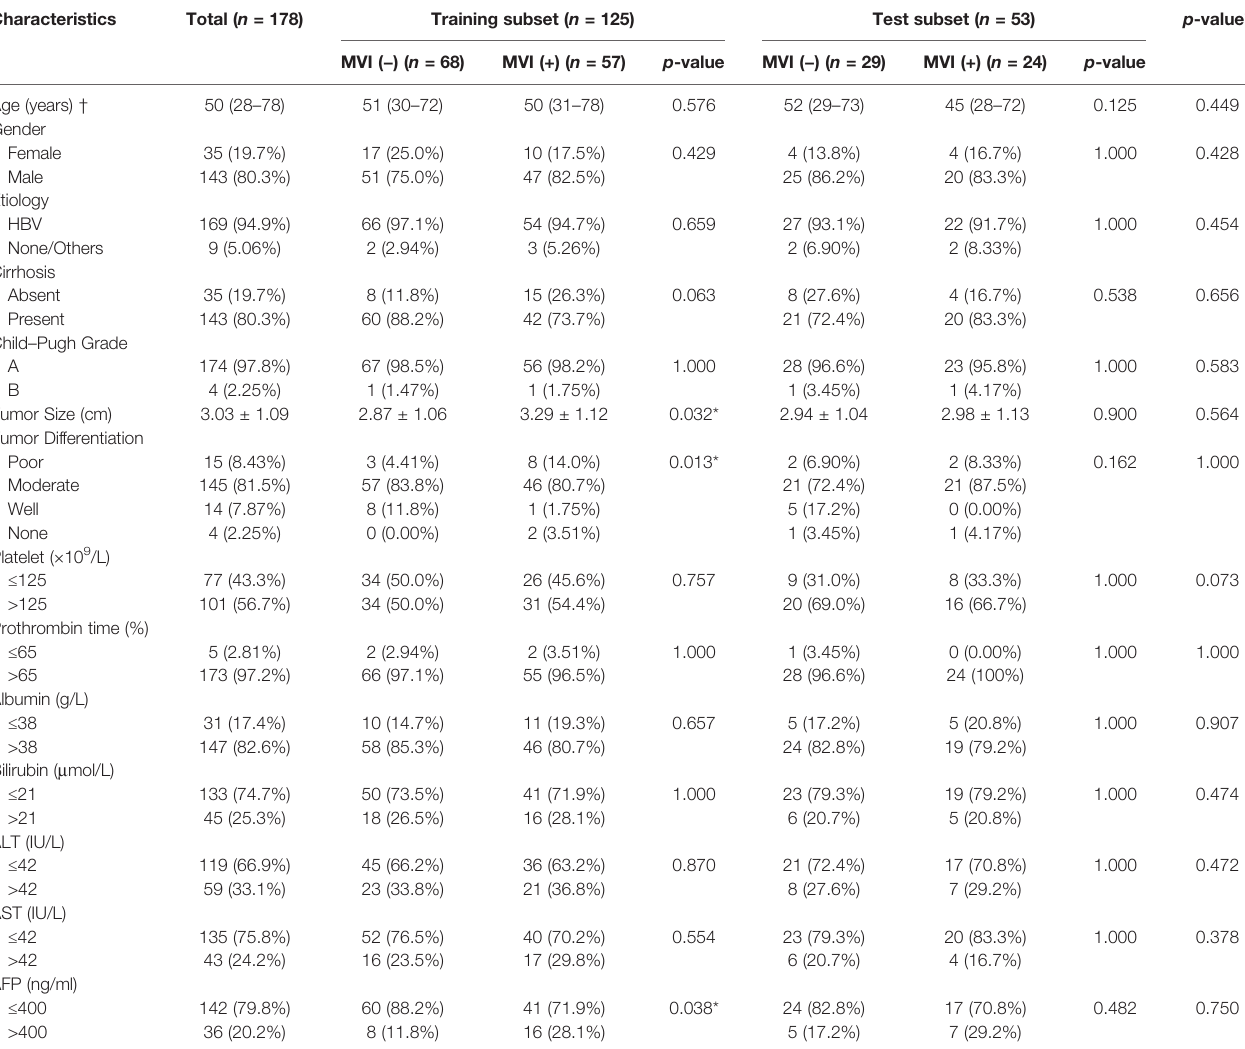
TABLE 1 | Clinicopathologic characteristics of the patients.